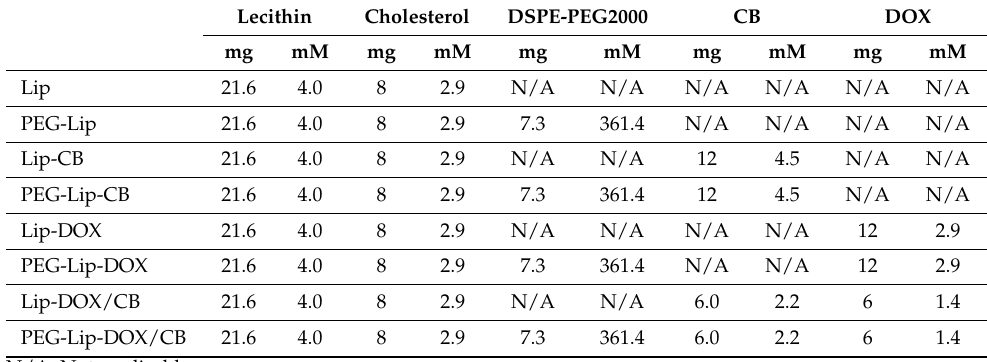
Table 1. Amount of source ingredients used to synthesize the